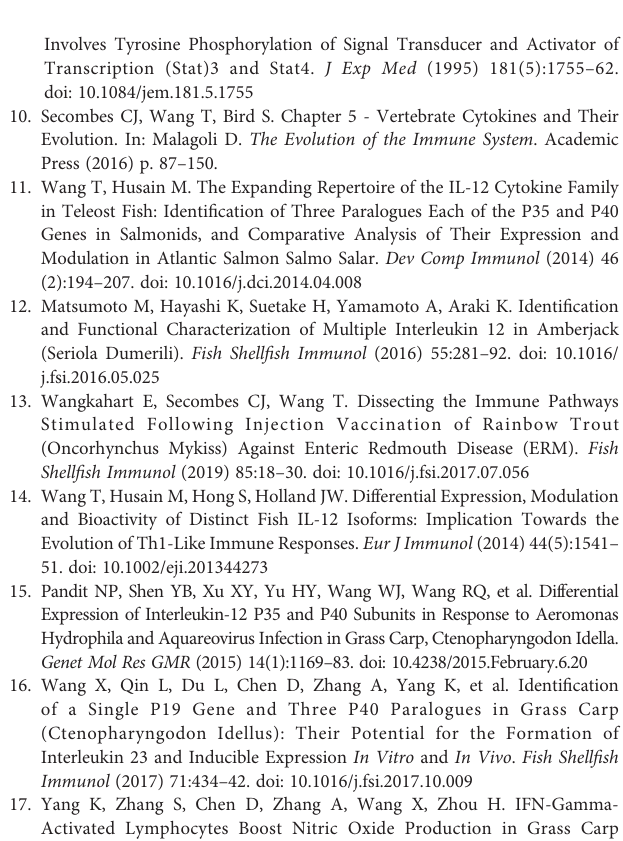
Supplementary Figure 4 | Inductive expression of gcp35a and gcp35b in grass carp monocytes/macrophages treated by poly I:C and rgcIfn- g for different times. Themonocytes/macrophagesweretreatedwithpolyI:C(50µg/mL) (A) andrgcIfn- g (500 ng/mL) (B) for 1, 6 and 12 h. The “ n.s. ” indicates no signi fi cant difference, ** p < 0.01, and *** p < 0.001. Data are shown as mean ± SEM (N = 4). Supplementary Figure5 | Molecular weightprediction andamino acid sequence alignments of the signaling molecules. (A) The predicted sizes of grass carp, human and zebra fi sh signaling molecules. (B) The amino acid residues surrounding phosphorylation sites of grass carp signaling molecules were aligned with the human or zebra fi sh homologues.